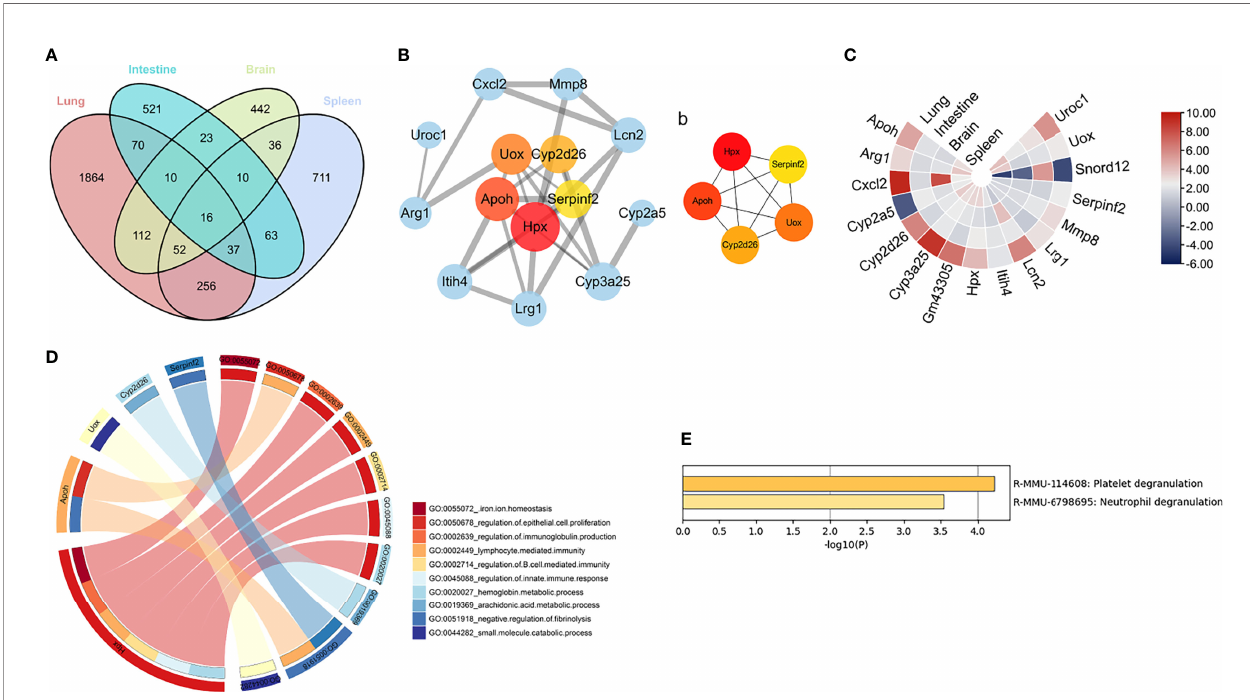
FIGURE 4 | Key genes and pathways in four organs (A) Venn diagram showing overlapping DEGs in four organs. Four organs shared 16 overlapping co-DEGs. (B) PPI network of co-DEGs; nodes in pink to red denote fi ve hub genes identi fi ed by “ cytoHubba ” . Thicker edges indicate stronger interactions between two proteins. Larger protein nodes indicate higher number of protein nodes with which the interaction is formed. (b) Networks of the fi ve hub genes identi fi ed by “ cytoHubba ” . Pink to red scale denotes p -value calculated by MCC method. (C) Heatmap of co-DEGs derived from integrated analysis. Each circle represents one organ, each sector represents one gene, and gradual color change from blue to red represents changing up-regulation. (D) GO term enrichment analysis of co-DEGs. Circos plot displays signi fi cantly enriched GO terms for fi ve hub genes. (E) All enriched terms were based on comprehensive enrichment analysis of KEGG and Reactome databases with “ Metascape ” . Co-DEGs, common differentially expressed